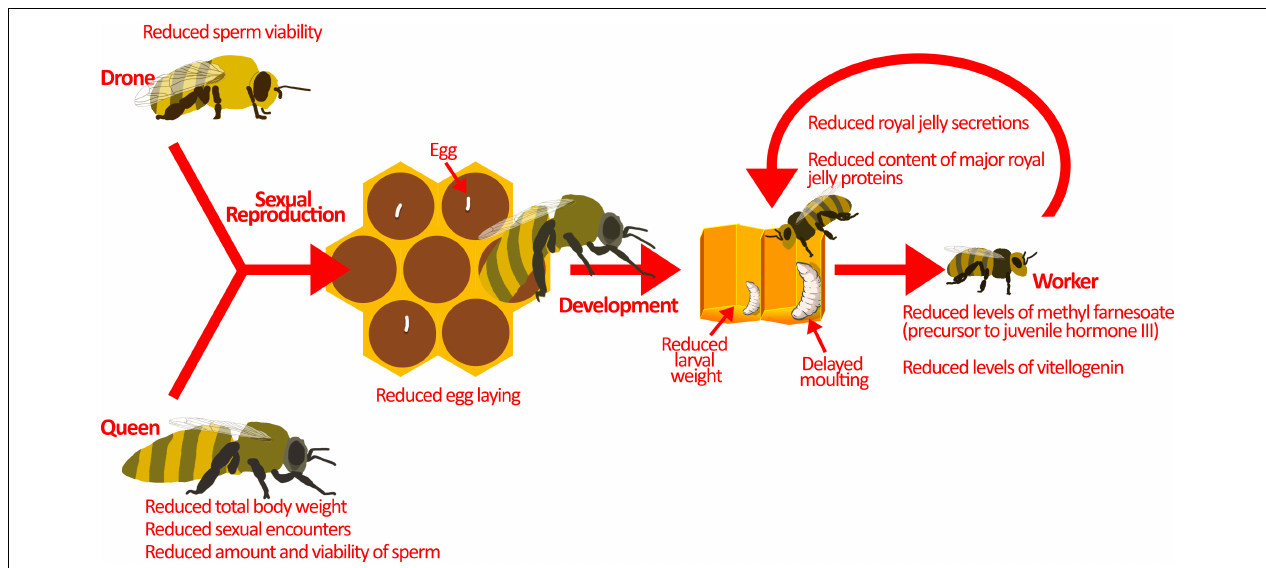
FIGURE 2 | Pesticides interfere with colony reproduction. Sexual reproduction between drones and the queen is the source of genetic diversity in the hive. This is important for pathogen resistance and colony survival. Sublethal pesticide exposure reduces sexual reproduction by affecting the drones and the queen. Drones exposed to pesticides have lower sperm viability. On the other hand, queens exposed to pesticides display reduced sexual encounters, sperm amount, and sperm viability. Moreover, pesticide exposed queens have smaller body weights, which may explain the reduction in sperm amount and egg-laying. Developing larvae are also at-risk during pesticide exposure. They demonstrate atypical progression through developmental phases, reduced larval weight, and delayed moulting. These may be a result of direct pesticide exposure, but pesticides could also be indirectly affecting larvae. Nurse bees exposed to pesticides produce reduced amounts of jelly secretions, and that which is produced has less nutritional value, potentially explaining the indirect effects of pesticides on honey bee larvae. Image of larvae in the hive is adapted from Maori et al. (2019) under Creative Commons Attribution 4.0 International (https://www.sciencedirect.com/science/article/pii/S10972765